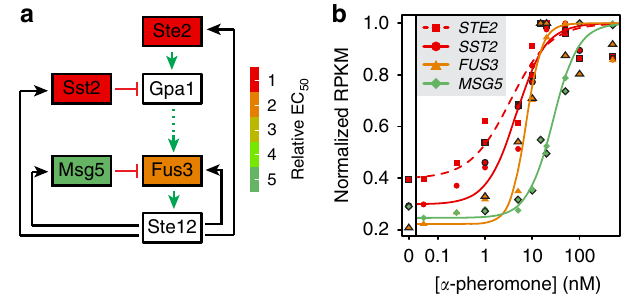
Fig. 1 Activation of the pheromone response pathway induces multiple feedback loops. a Simpli fi ed depiction of the pathway and its feedback regulators. Activation of the pheromone receptor Ste2 leads, through a signalling cascade, to activation of MAP kinase Fus3. Fus3-dependent phosphorylation of transcriptional activator Ste12 stimulates the expression of Ste2 and Fus3 as well as of two negative pathway regulators: Sst2, a GTPase activating protein (GAP) for G α protein Gpa1; and Msg5, a phosphatase for Fus3. These upregulated components are coloured according to relative EC 50 values (normalized to the lowest value, approximately 4 nM for STE2 ) of their mRNA dose responses; mRNA levels of pathway components in white boxes were not upregulated. Black arrows denote transcriptional feedback regulation, green (dashed) arrows denote (indirect) activation and red blunt-end arrows indicate inhibiting activity. b Dose dependence of pheromone activation for the indicated genes encoding pathway components. Shown are normalized RNA levels as measured in two independent RNA sequencing experiments (symbols with and without frames, respectively) at 60 min after addition of respective dose of pheromone in a strain deleted for α -pheromone protease gene BAR1 (Supplementary Table 1). Lines are fi ts with a sigmoidal function used to infer EC 50 values, used for the colour scale in a , b . Fig. 2 Negative feedback regulators improve accuracy of input estimation